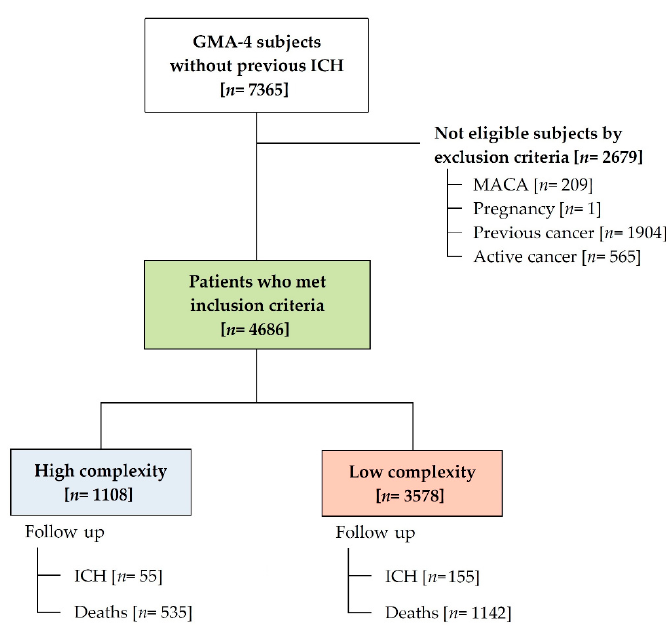
Figure 1. Flow diagram of the study: participant selection (included and excluded), distribution in groups and follow-up according to ICH occurrence. ICH—intracerebral haemorrhage; MACA (Catalan acronym for Advanced Chronic Care Model)—diagnosis of progressive and irreversible chronic disease unlikely to respond to specific treatments and with a limited life prognosis. Out of 4,686 participants analysed, 57.2% were women, and the median age was 84 years (IQR from 75 to 90); 93% of the population was ≥ 65 years old, and 64.3% were ≥ 80 years old. Follow-up time was 5 years (IQR from 3.7 to 5.0), differing between patients who suffered an ICH event and patients with no ICH (ICH 2.6 years (IQR from 1.3 to 3.6) vs. no-ICH 5 years (IQR from 4.0 to 5.0), p < 0.001). Table 1 shows the baseline characteristics of the study population according to ICH